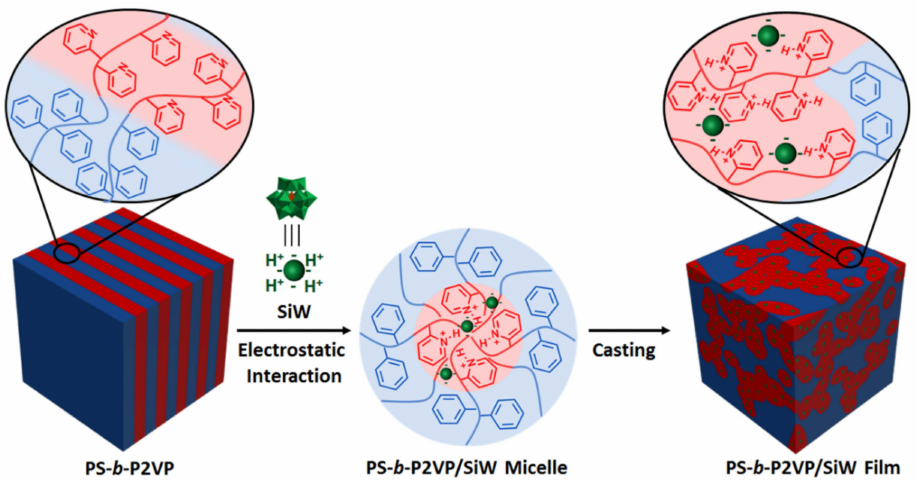
Figure 8. The SiW-induced phase transition of PS-b-P2VP from a lamellar to a bicontinuous structure upon casting the PS-b-P2VP / SiW micelle solution. Reproduced with permission from [46]. Copyright (2017) John Wiley and